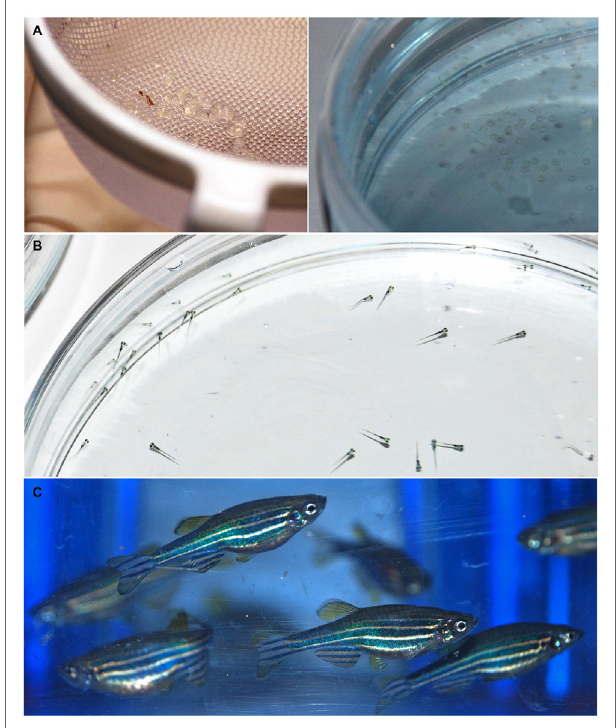
FiguRe 1 | Representative images of zebrafish at embryonic (a) , larval (B) , and adult (c)